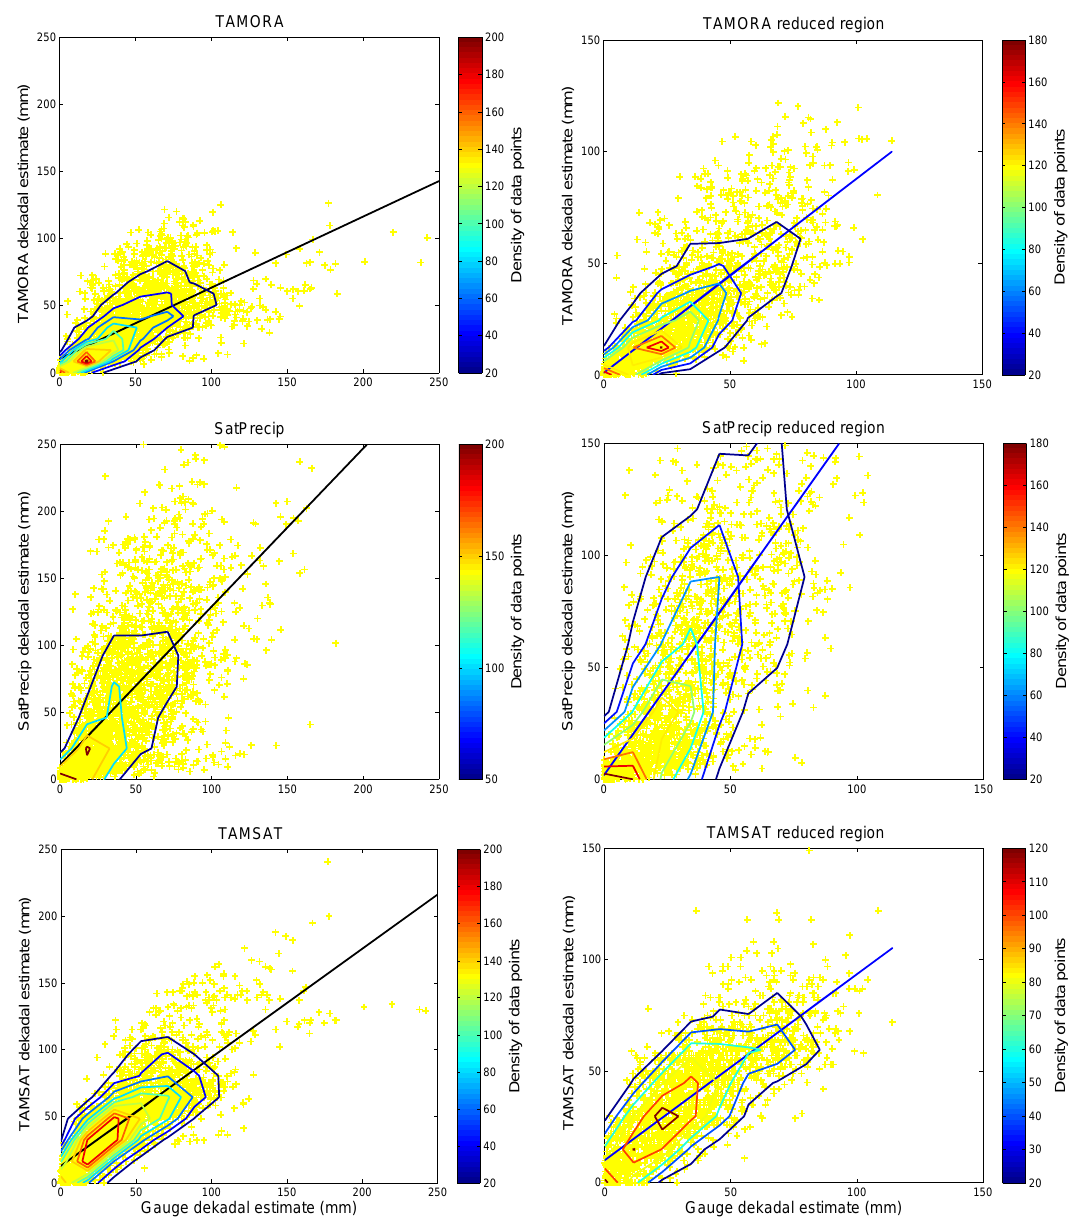
Fig. 3. Density of TAMORA, SatPrecip and TAMSAT estimates plotted against corresponding kriged gauge estimates at 0.5 ◦ , 10 day scale, for JAS 2004. Least squares fit lines are also shown. (L) All grid squares within the validation area of 10 to 17 ◦ N, − 17.5 to 21.5 ◦ E were used. (R) Only grid squares where the JAS 2004 kriged gauge total was ≤ 500mm were